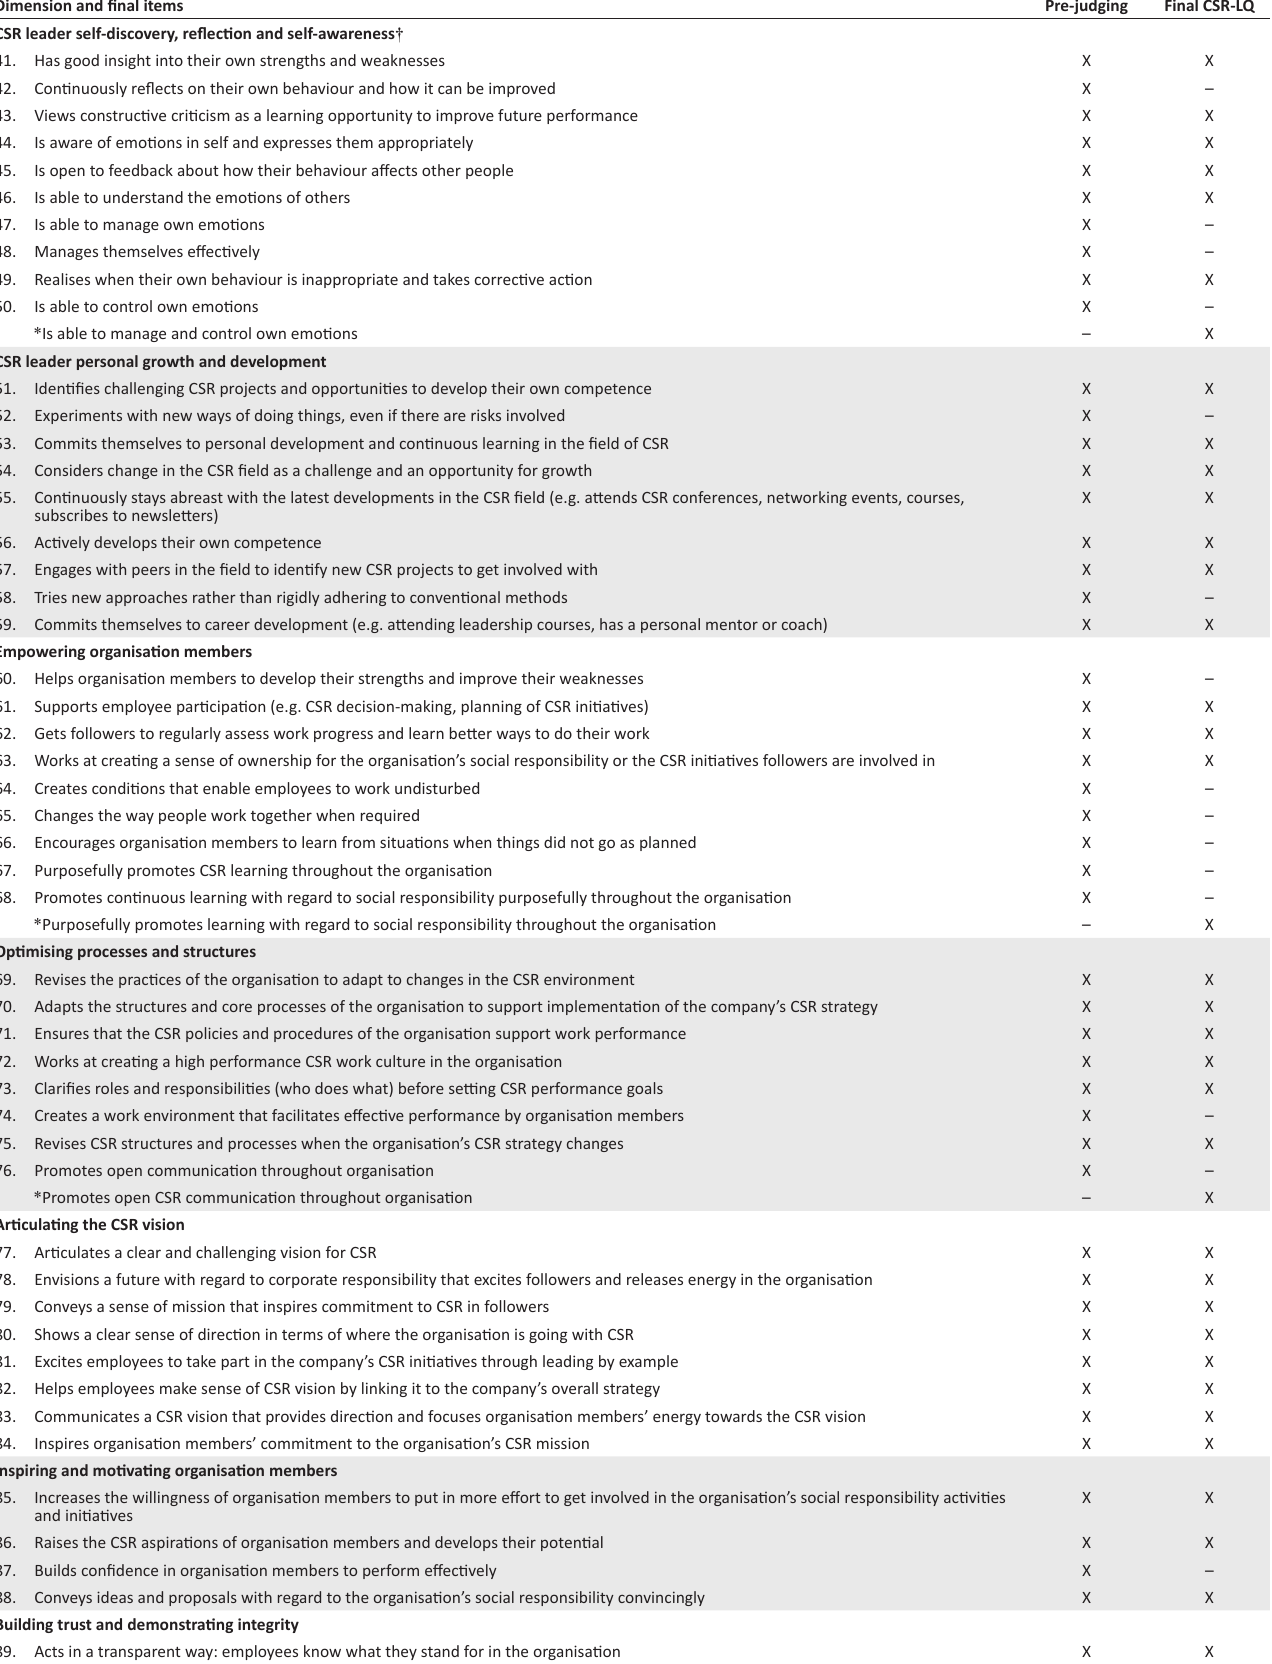
TABLE 4 (Continues...): CSR-LQ items prior to and after expert